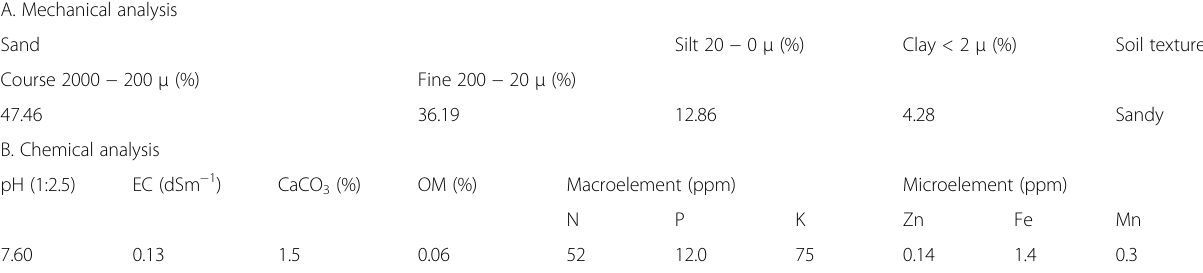
Table 1 Mechanical and chemical analyses of the experimental soil